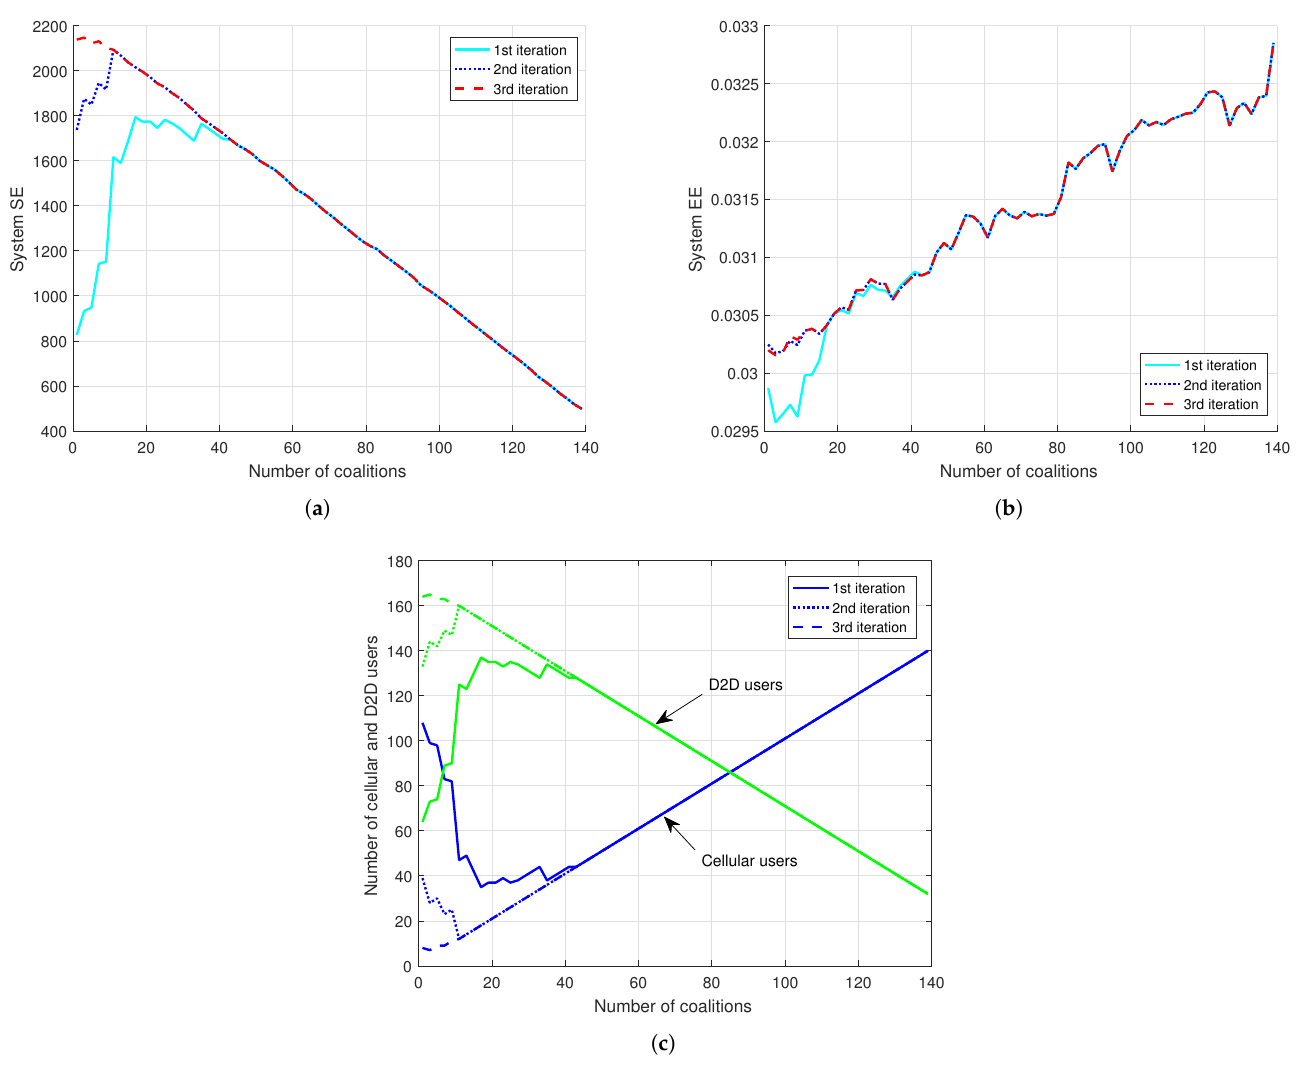
Figure 7. Proposed cooperative NOMA vs. number of coalitions. ( a ) System’s SE; ( b ) System’s EE; ( c ) Evolution of the number of D2D and cellular